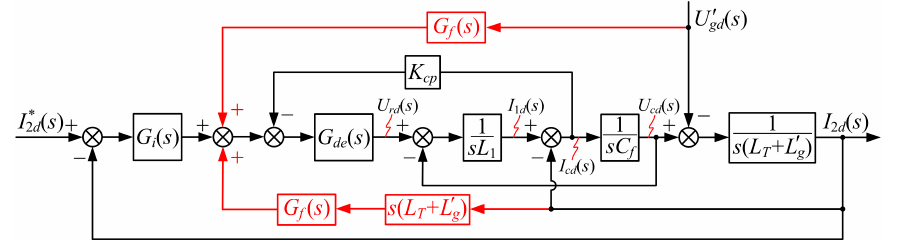
Figure 4. Equivalent control block of grid current.